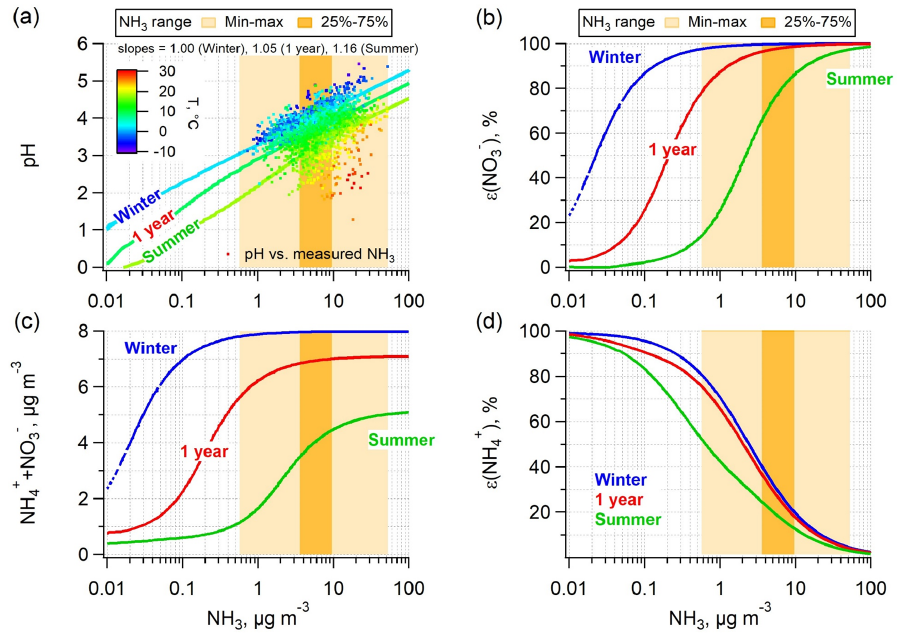
Figure 3. Prediction of (a) particle pH; (b) particle-phase fractions of total nitrate, ε (NO − ); (c) ammonium and nitrate mass concentra- 3 tion; and (d) particle-phase fractions of total ammonium, ε (NH + ), for a wide range of ammonia. The simulations are based on the 1-year 4 (July 2012–June 2013), summer (June–August 2012), and winter (December 2012–February 2013) average conditions at the Cabauw site + NH with NH x (NH + 3 ) left as a free variable. The measured NH 3 ranges for the 1-year span are also shown as the lighter (min–max) and 4 darker (25%–75% percentiles) orange-color zones. Plot (a) also includes the predicted pH versus measured NH 3 data for the entire study and colored by ambient